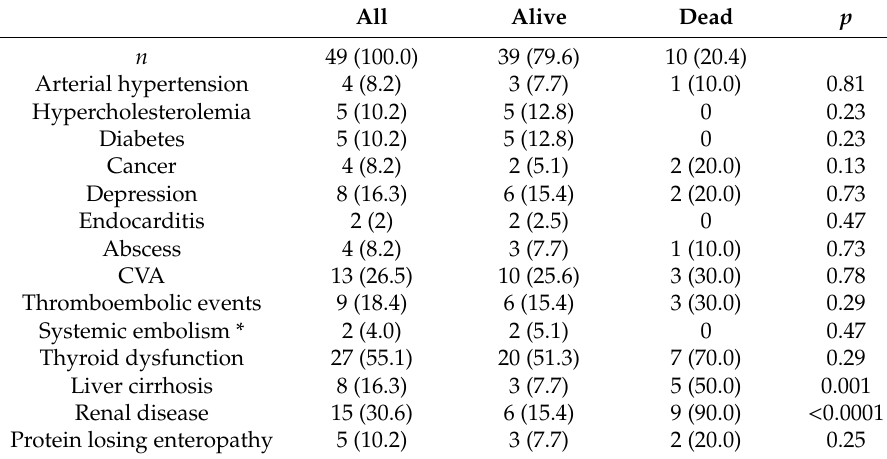
Table 2. Comorbidities at baseline, n